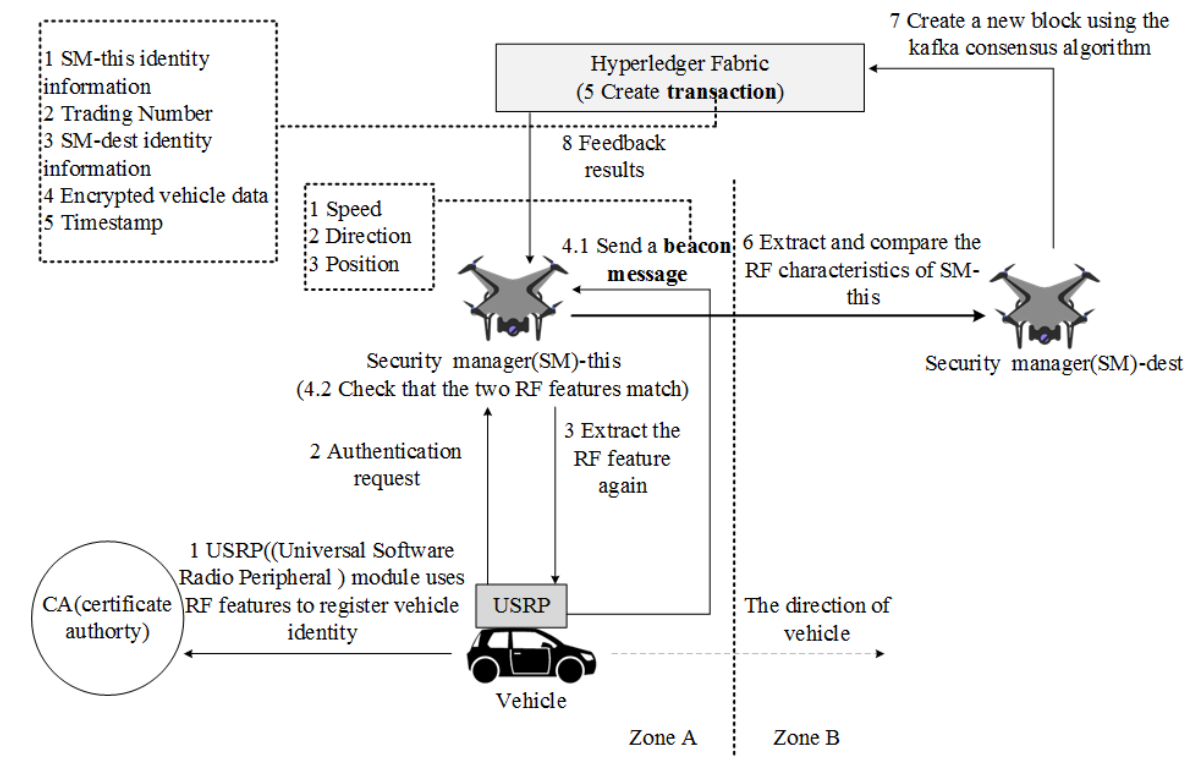
Figure 35. Reconstruction diagram of reference [67].